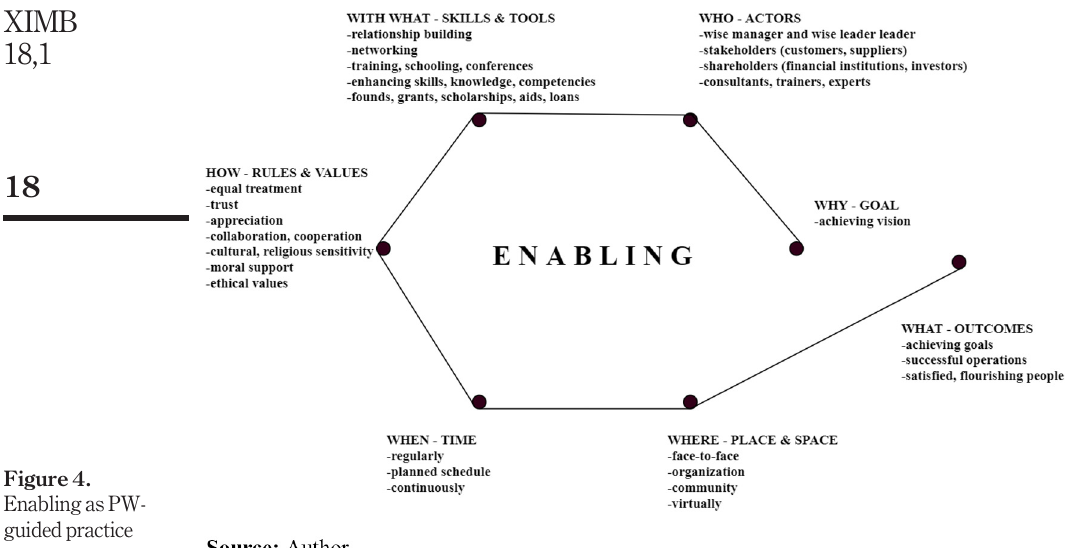
Figure 4. Enabling as PW- guided practice